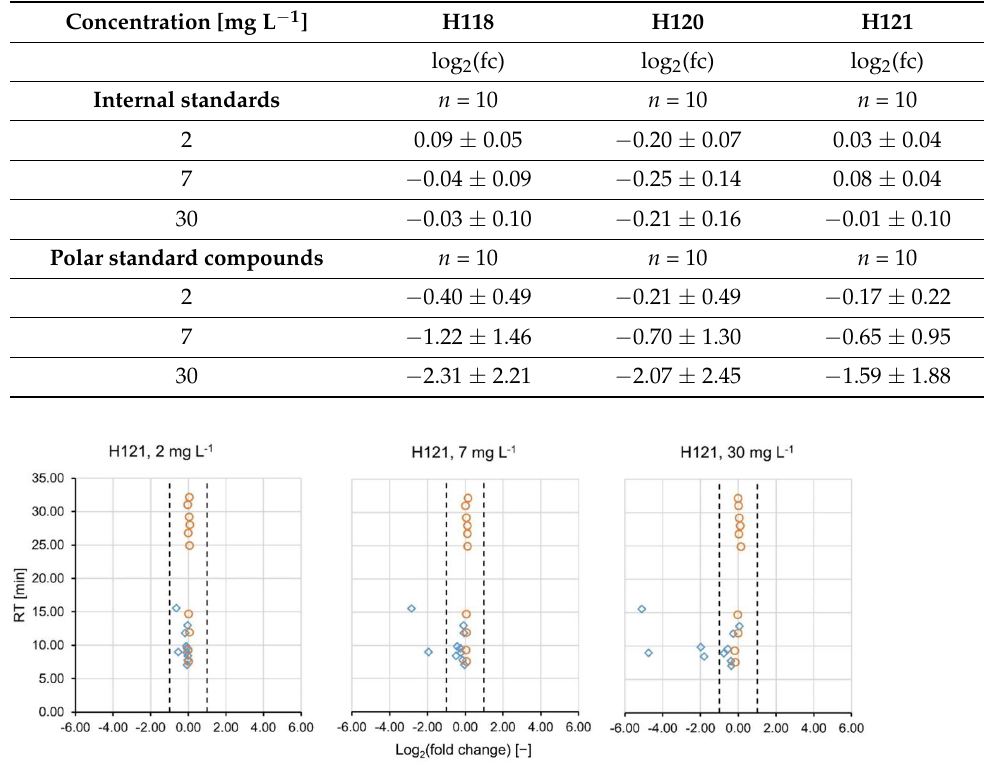
Table 1. Means and standard deviations of log 2 (fc) values for the internal standards and the polar standard compounds measured in the positive ionization mode. H118, H120 and H121 are the laboratory names of the different PAC types which were tested for surface water treatment at three different concentrations.